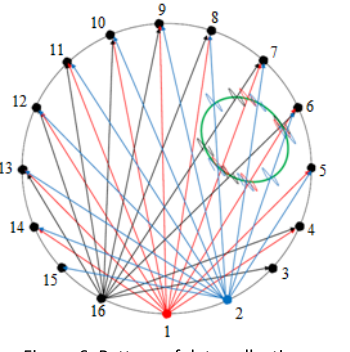
Figure 6: Pattern of data collection